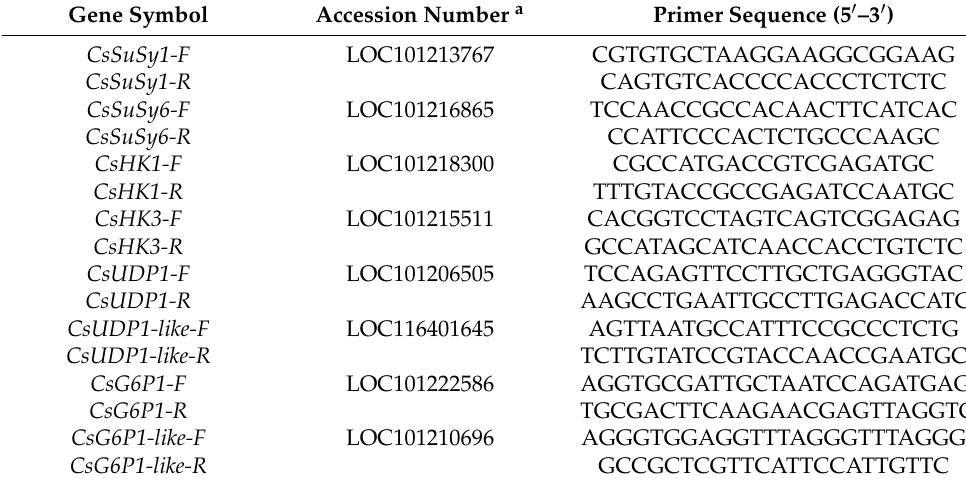
Table 2. Sequences of primers used for RT-PCR analysis. Gene